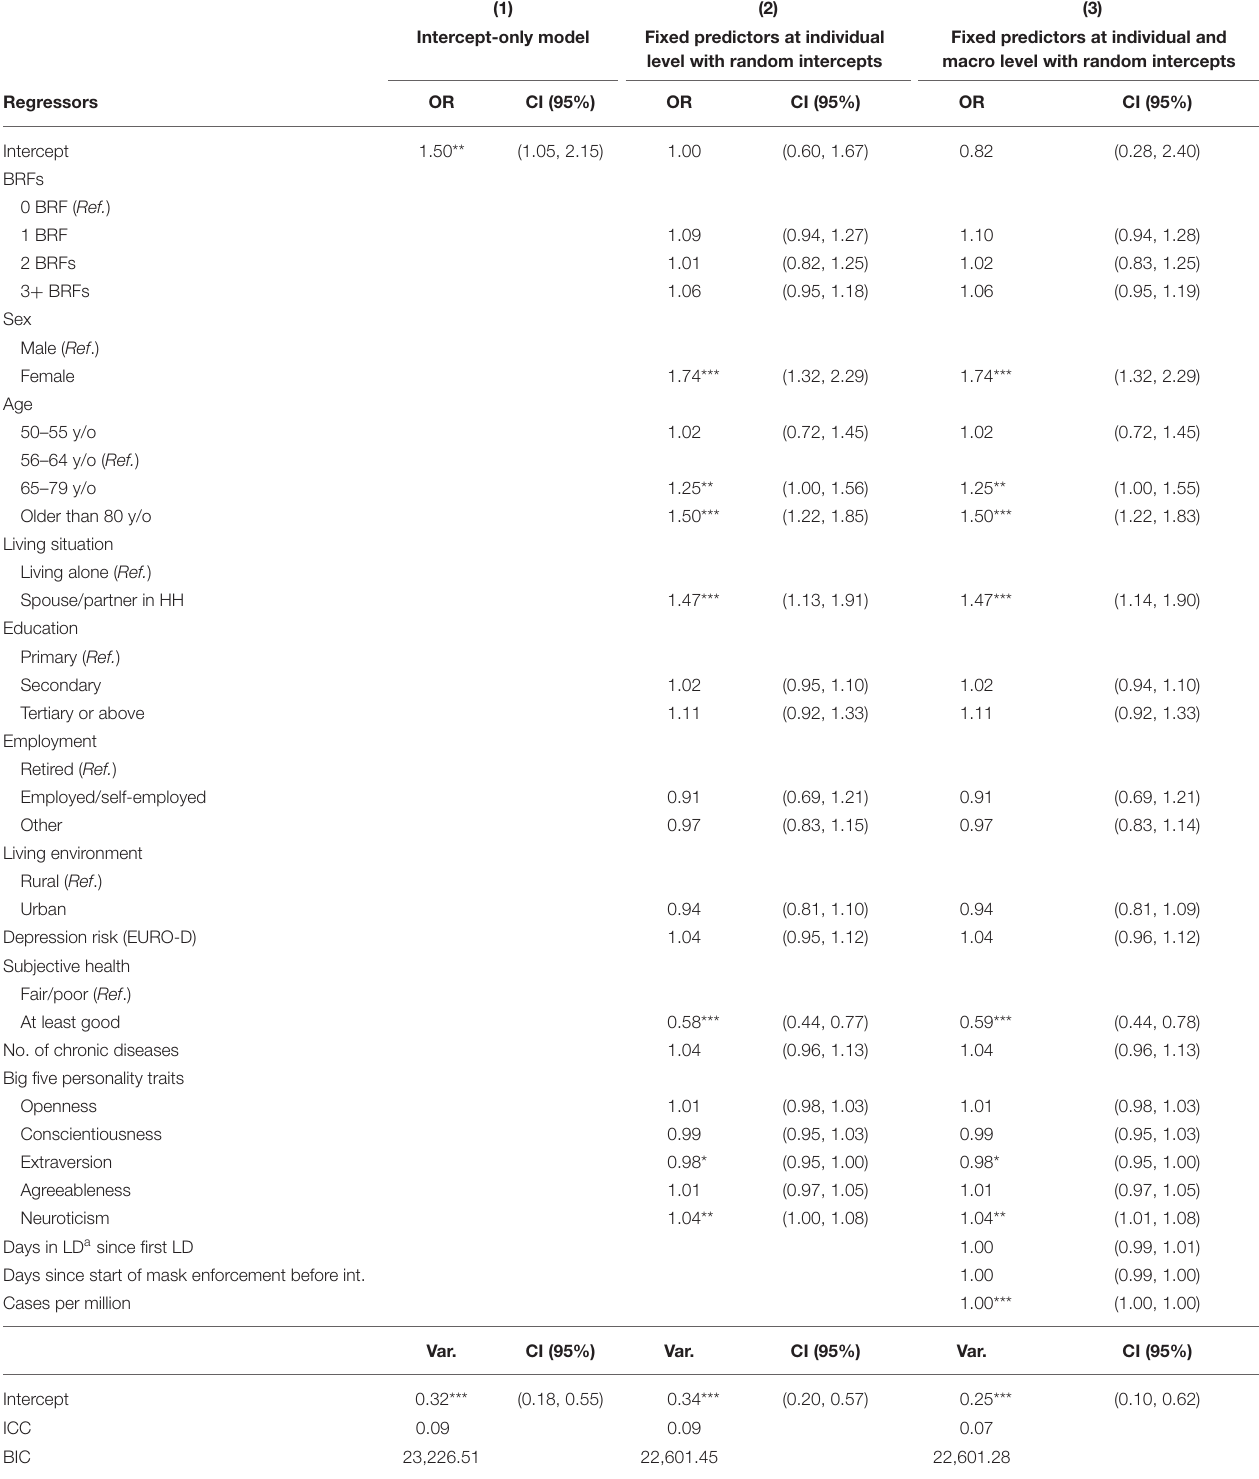
TABLE 3 | Multilevel analyses predicting adherence to social isolation ( n = 17.588), Data: Wave 8 Release 0.0.1 beta. (1) (2) (3) Intercept-only model Fixed predictors at individual Fixed predictors at individual and level with random intercepts macro level with random